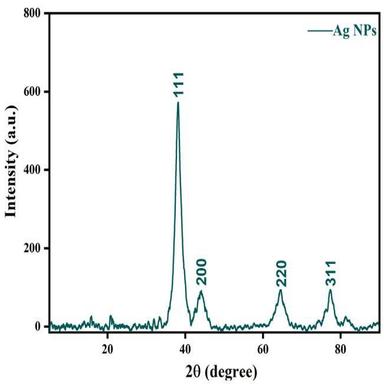
X-ray diffractogram of Ag NPs.